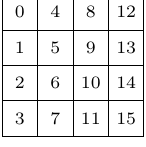
Figure 18: AES byte ordering